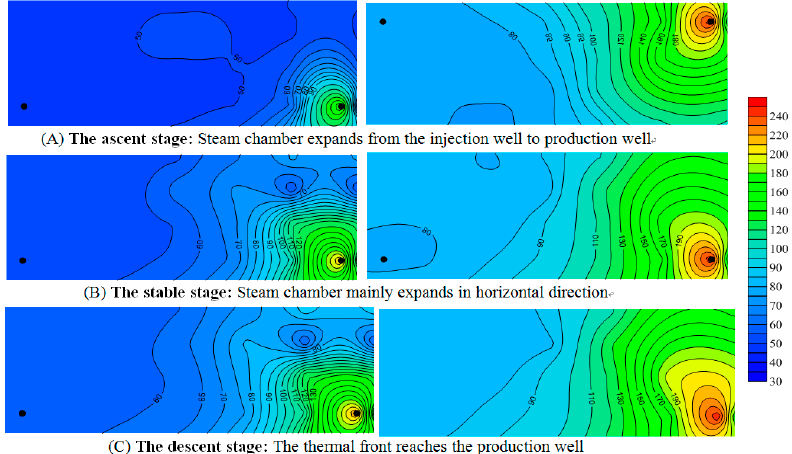
Figure 4. Nitrogen-assisted steam temperature field distribution [94].